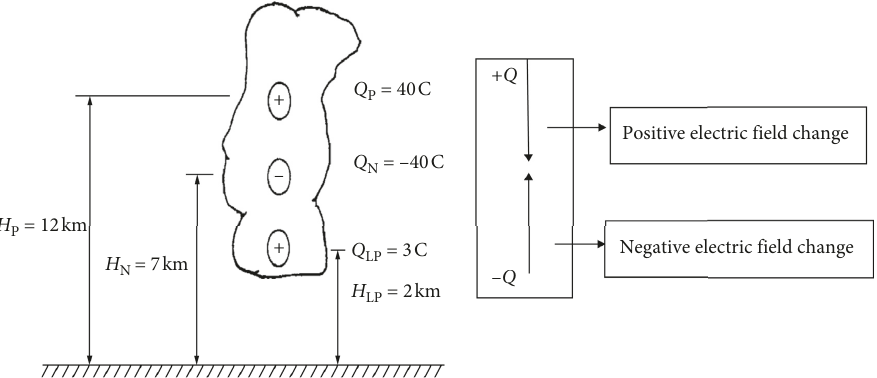
Figure 2: An idealized vertical tripole structure of a thunderstorm (adopted from